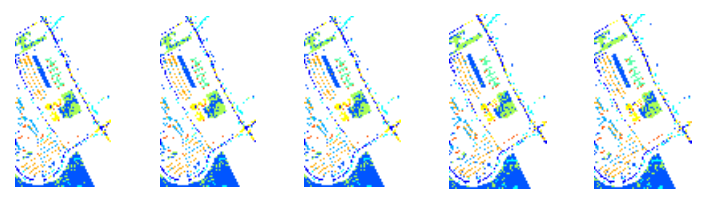
Figure 5 (continue). The obtained class maps with (cid:13)